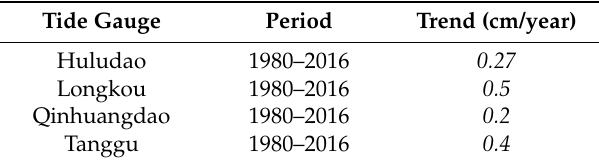
Table 1. Mean sea level trends at four tide gauges a